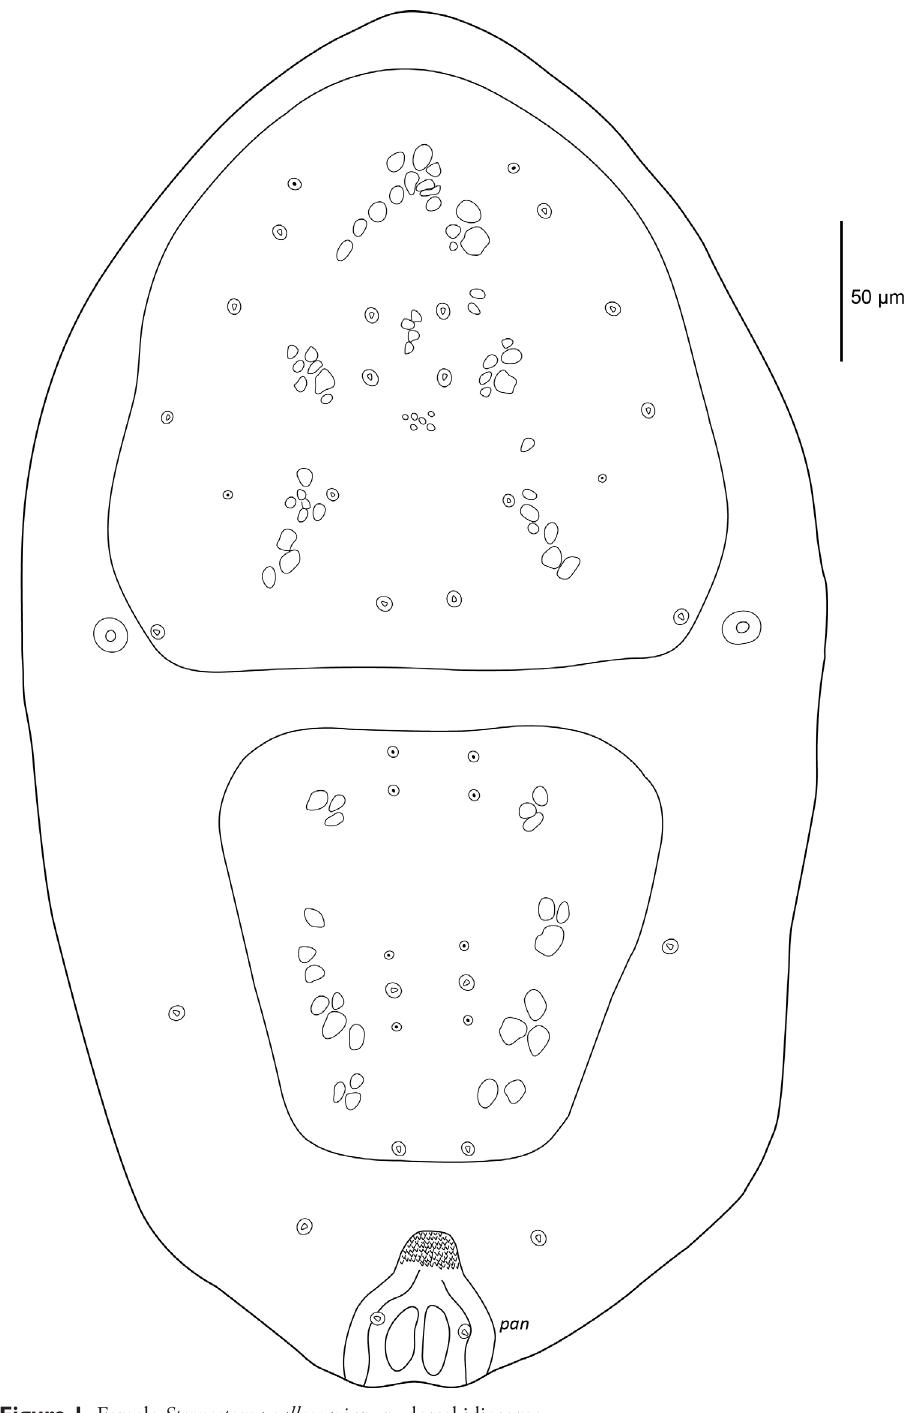
Figure 1. Female Sternostoma gallowayi sp. n. dorsal